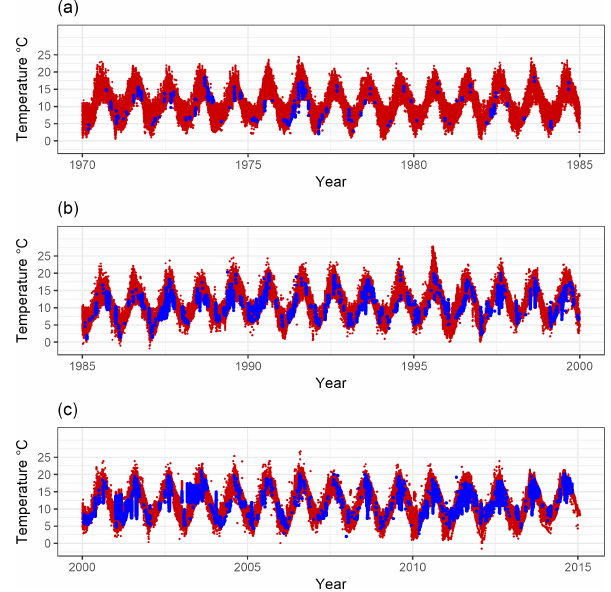
Figure 16. Seawater temperature cycles for three 14-year periods: 1970–1984 (upper chart), 1985–1999 (centre chart), and 2000–2015 (lower chart) for seas around the British Isles (area 48 to 58 ◦ N and 10 ◦ W to 10 ◦ E), separating near-surface 0–5m (red) and 20–25m (blue)